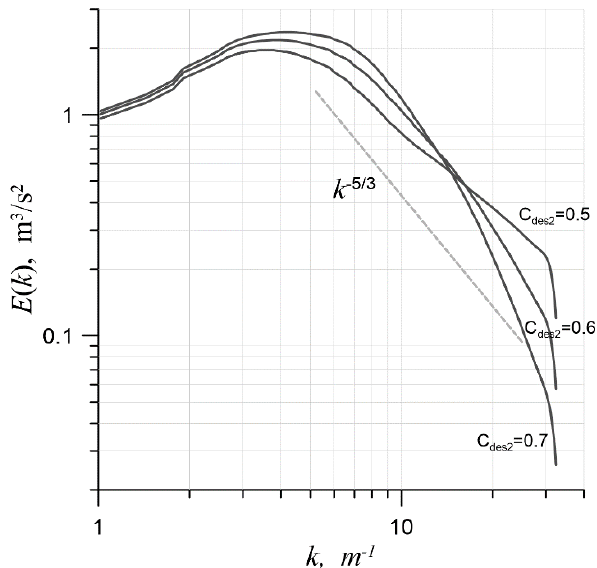
Figure 9. The energy spectra on a mesh with 64 3 cells at different values (0.5, 0.6, 0.7) using a hybrid scheme.